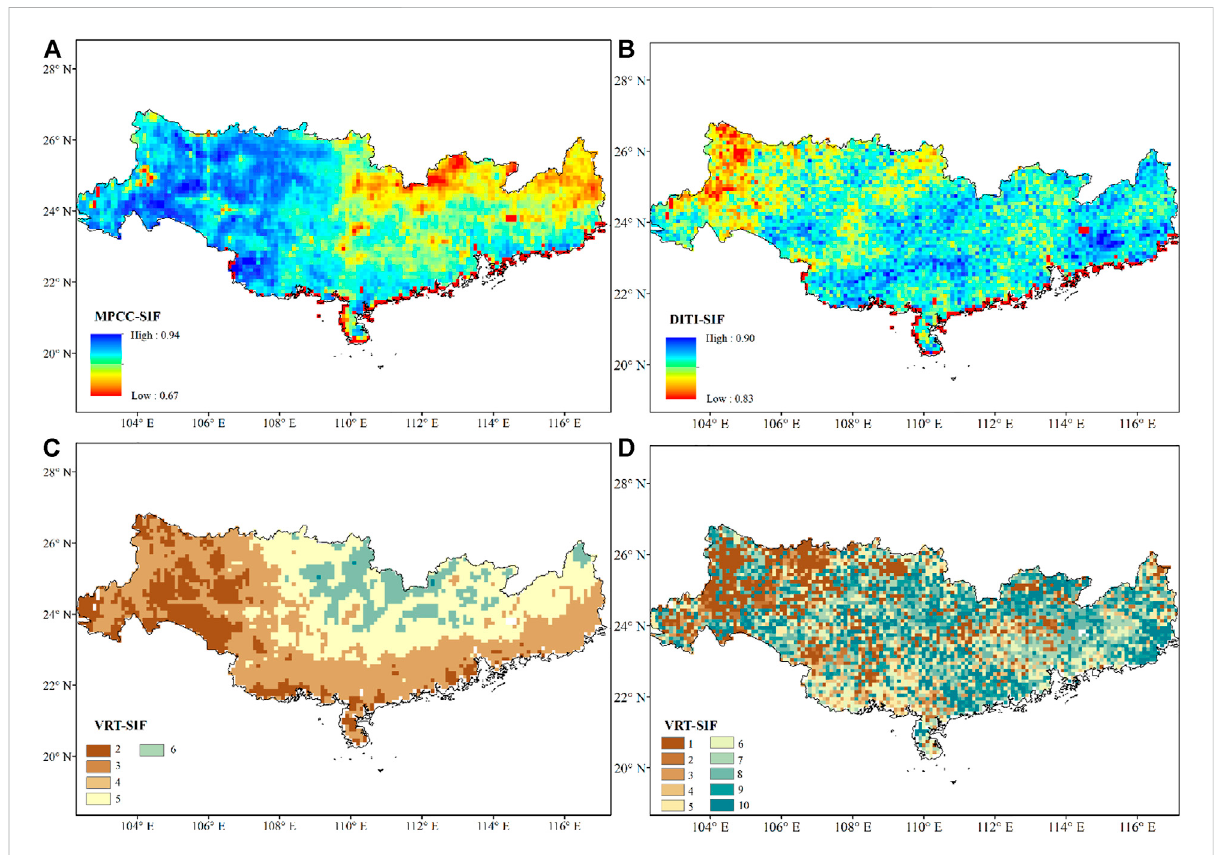
FIGURE 6 Spatial distributions of the MPCC (A) and the DITI (B) and corresponding VRT (C,D) are based on